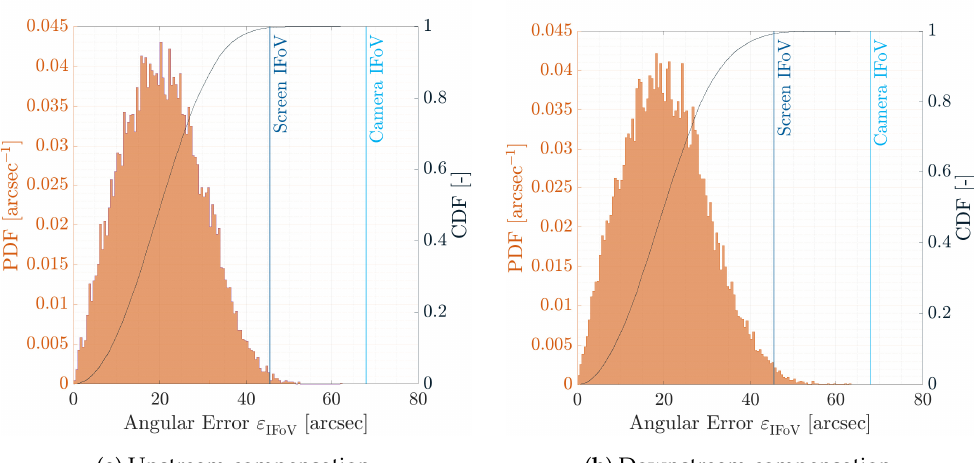
Figure 16. PDF and CDF for the error norm ε vertical lines are the facility iFoV θ f